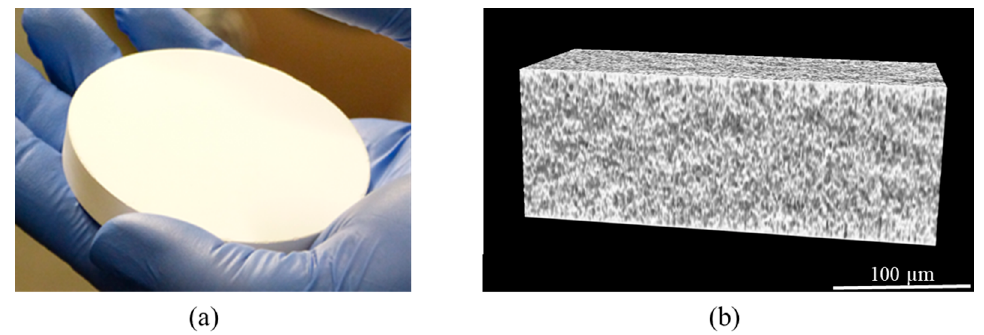
Figure 5. View of a green compact of Nd:YAG in the form of a pellet with a 80 mm diameter and 12 mm thickness obtained by the pressure slip-casting of suspensions with 30 vol.%, 1 wt.% of PAA, and pH = 9 ( a ) and a corresponding micrograph obtained by X-ray microtomography ( b ).